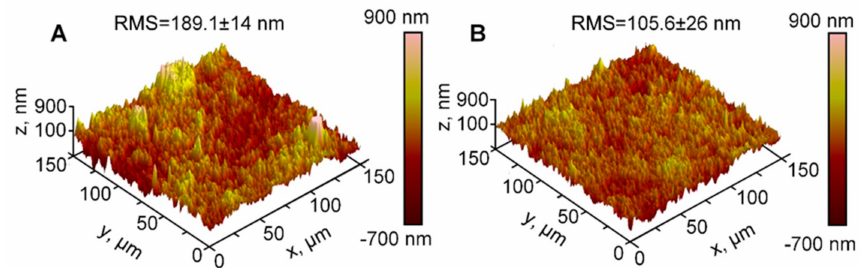
Figure 3. AFM images of surface roughness of: ( A ) fresh Velostat ® and ( B ) used Velostat ® . RMS—roughness parameter root mean squared, calculated using the method described elsewhere